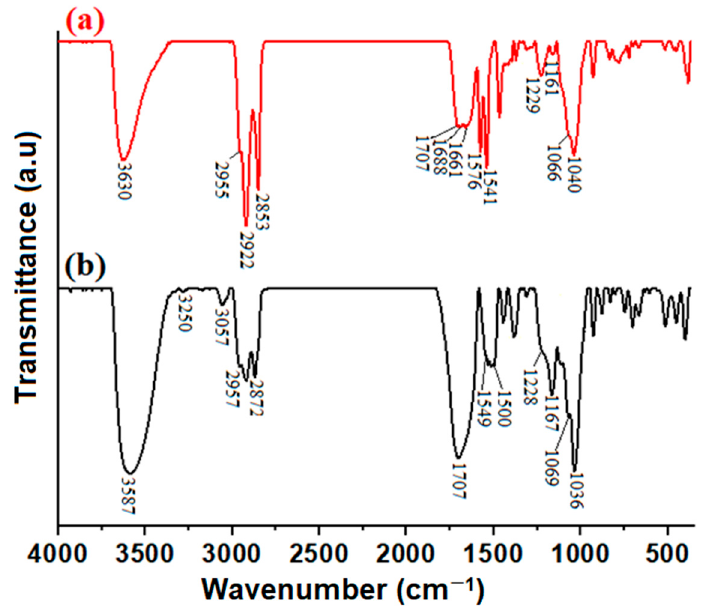
Figure 2. EDX spectra and the elemental composition (inset) of: ( a ) oxidized wool fibers, ( b ) oxidized wool fibers, ( c , d , e ) oxidized wool fibers loaded with Cu 2+ , Cd 2+ , respectively Pb 2+ .